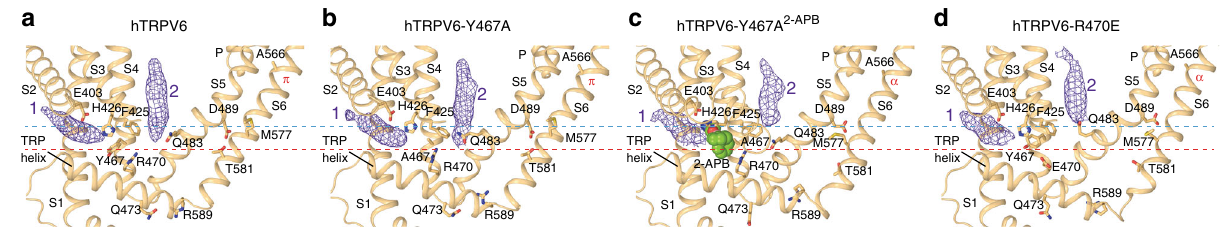
Fig. 9 Densities for S1 – S4 and activating lipids in cryo-EM structures of hTRPV6. a – d Close-up views of the transmembrane domain of a single subunit in the cryo-EM structures of hTRPV6 ( a PDB ID: 6BO8), hTRPV6-Y467A ( b ), hTRPV6-Y467A 2-APB ( c ), and hTRPV6-R470E ( d PDB ID: 6BOA) viewed parallel to the membrane. The molecule of 2-APB is shown as a space- fi lling model (green). Purple mesh shows cryo-EM density for the S1 – S4 (1) and activating (2) lipids, low pass fi ltered to the same (4.44 Å) resolution. Red and blue dashed lines indicate the lowest (most intracellular) levels reached by the activating lipids in the open (hTRPV6 and hTRPV6-Y467A) and closed (hTRPV6-Y467A 2-APB and hTRPV6-R470E) structures, respectively. The local π and α helical conformations of S6 associated with the open and closed states, respectively, are indicated (red